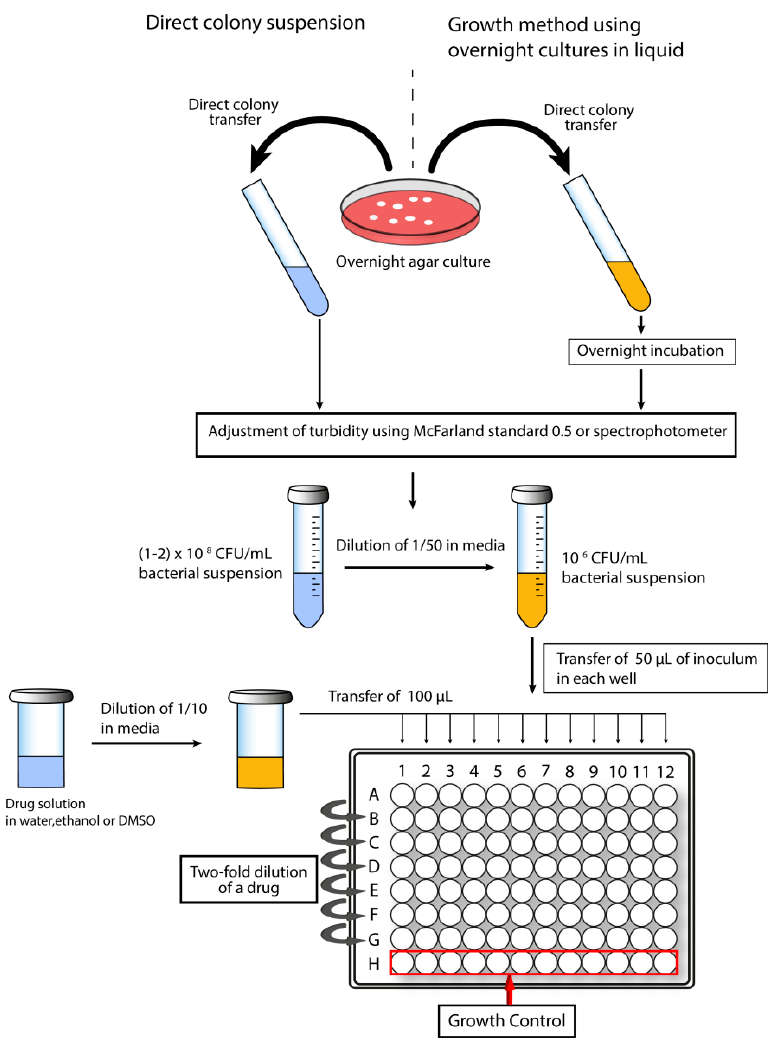
Figure 2. Determination of minimal inhibitory concentration by the broth microdilution method.